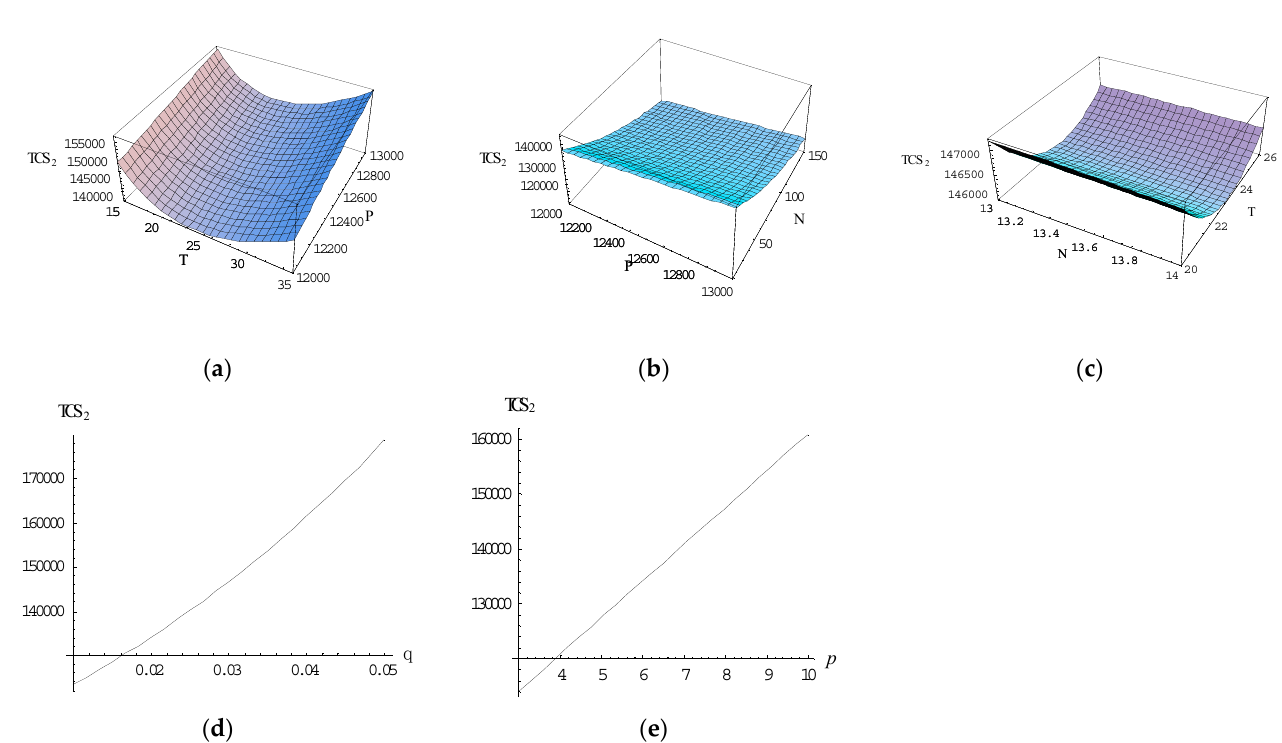
Figure 5. ( a ) Nature of total cost with respect to producer’s cycle length and production rate. ( b ) Nature of total cost with respect to credit period and production rate. ( c ) Nature of total cost with respect to producer’s cycle length and credit period. ( d ) Integrated cost for the products versus the deterioration rate. ( e ) Integrated cost for the products versus selling price. Table 3. Sensitivity analysis of key parameters of the